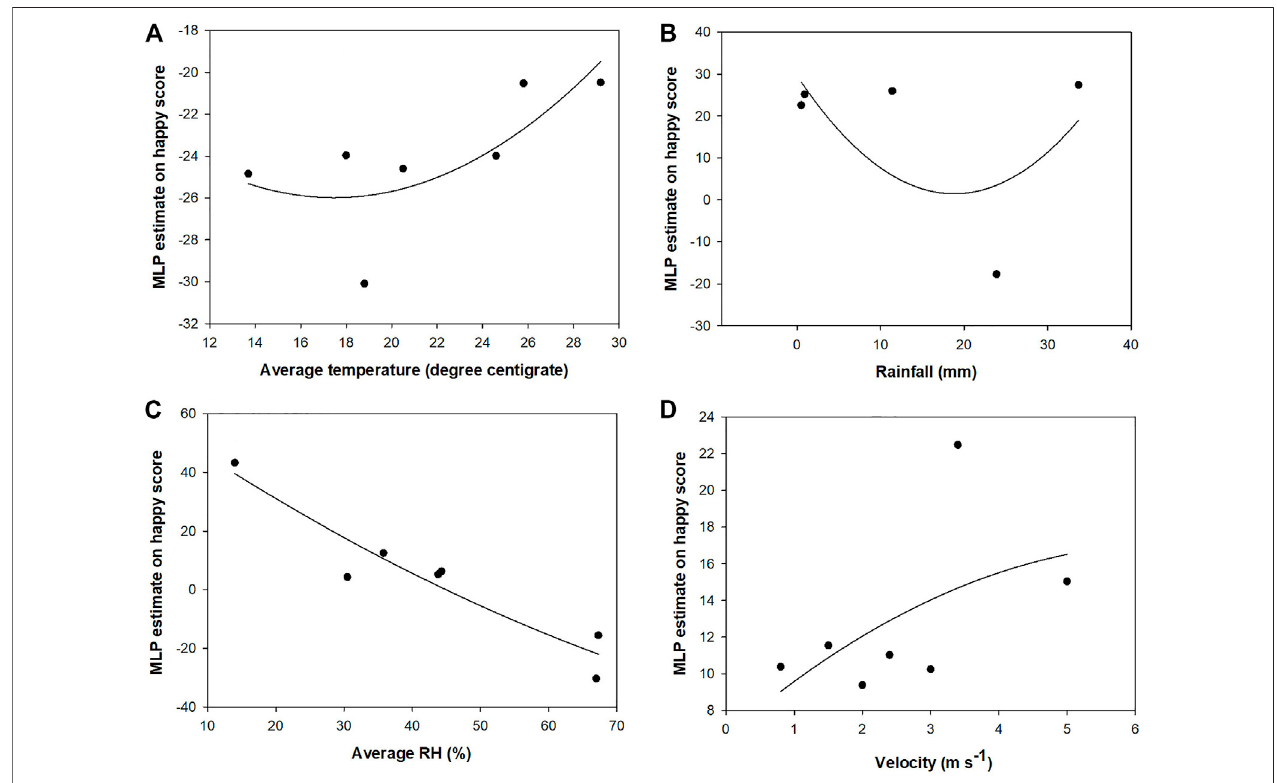
FIGURE5| Binomial regressionofmaximumlikelihoodparameter (MLP)estimatesofclimatic factors(averagetemperature, (A) ;rainfall, (B) ;averageRH, (C) ;wind velocity, (D) ) on happy scores. Spots are signi fi cant MLP estimates of an existing microclimatic record indicated by a zero-in fl ated negative binomial model. Data are derived from Supplementary Table S3 . Coef fi cients of regressed models can be found in Table 2 .